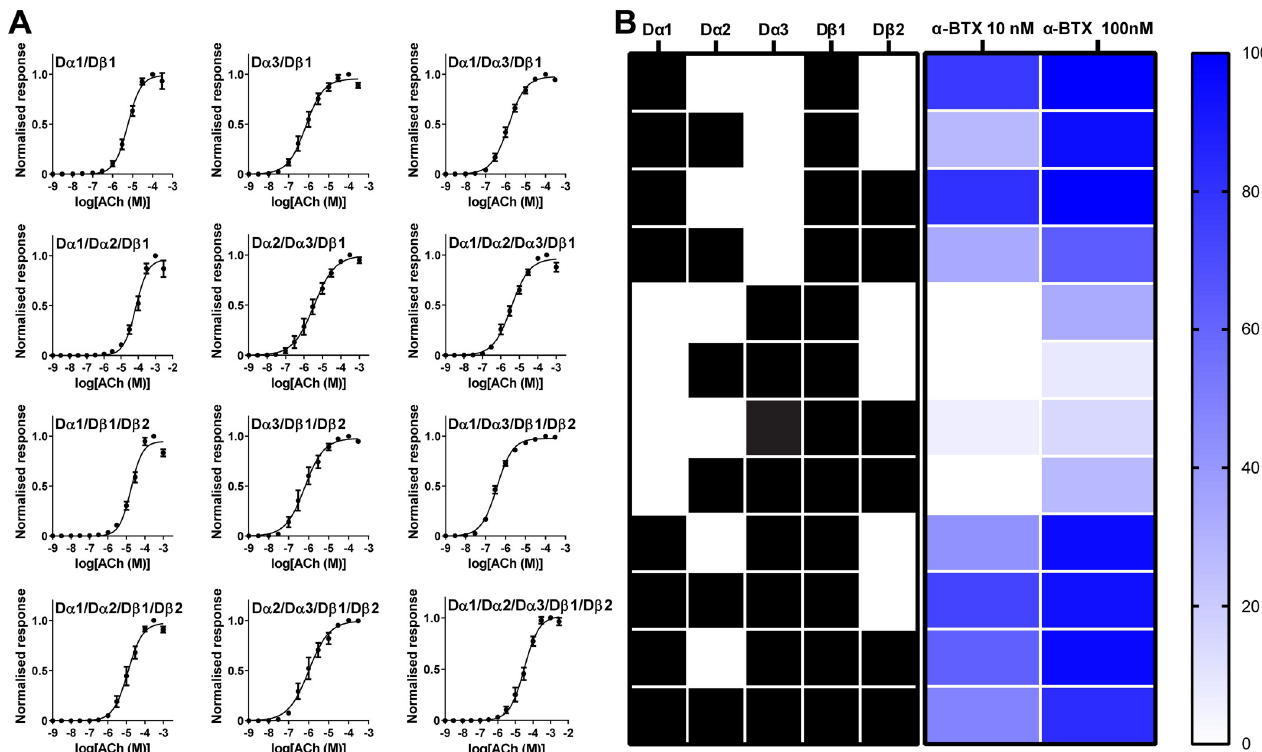
Fig 2. Concentrations-response relationships of ACh for D . melanogaster nAChRs expressed in X . laevis oocytes and actions of α -BTX on the ACh- induced responses of nAChRs. ( A ) Concentration-response curves of ACh and ( B ) heatmap representing α -BTX for the 12 nAChRs expressed in X . laevis oocytes. In ( A ), each data plot indicates the mean ± standard error (n = 5). In ( B ), high to low α -BTX sensitivity is shown in blue and white, respectively. The D α 1 subunit underpins the α -BTX sensitivity of the nAChRs tested. See Fig B in S1 Text for the ACh-induced currents measured in the absence and presence of α -BTX ( Fig Ba in S1 Text) and bar graph representations of the effects of α -BTX ( Fig Bb in S1 Text ).